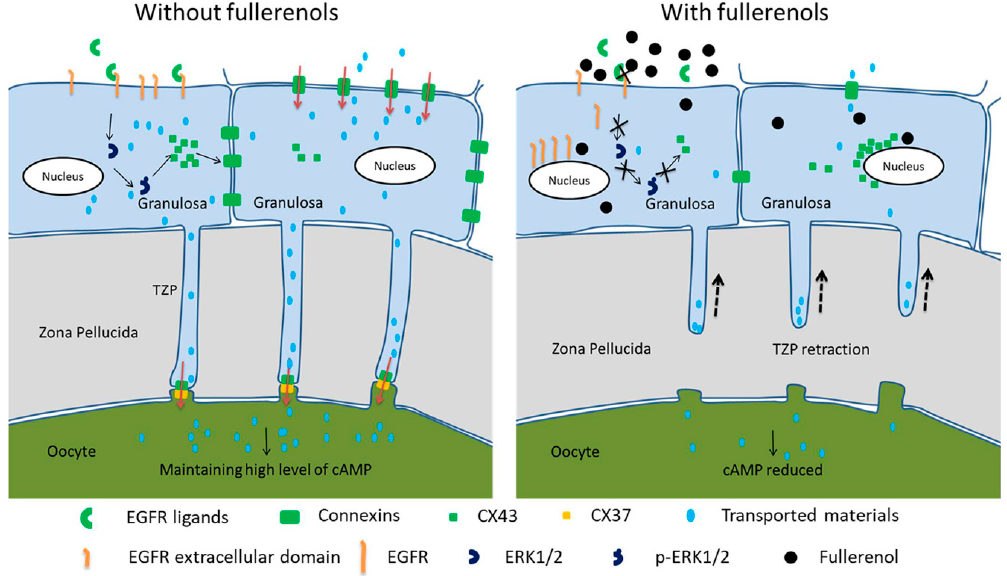
Figure 8. Schematic representation of effects of fullerenol nanoparticles on oocyte meiosis resumption. Fullerenol nanoparticles occluded extracellular domain of epidermal growth factor receptor (EGFR) to inhibit ligand-EGFR binding-mediated extracellular regulated kinase 1 and 2 (ERK1/2) activation. Then, connexin 43 (CX43) expression was downregulated, resulting in TZP retraction (dashed arrows) and reduction of gap junction-based material transport, which decreased cAMP in oocytes. Moreover, fullerenol nanoparticles caused perinuclear distribution of CX43 and EGFR, which further exacerbated the effects. Black arrows mean the signal transduction of EGFR mediated ERK1/2 activation and black cross (X) means fullerenol’s inhibitory effect. Orange arrows indicate material flow from granulosa cells to oocyte via TZPs.